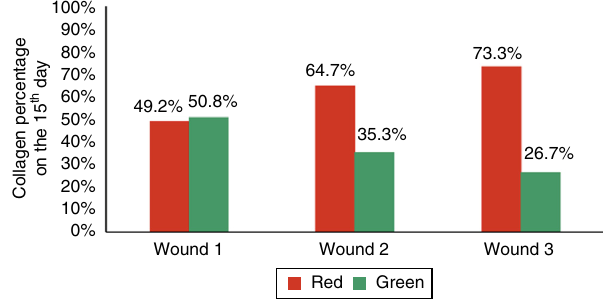
Demonstration of the percentage of type I and type III collagen on the 15th day of the experiment in the three